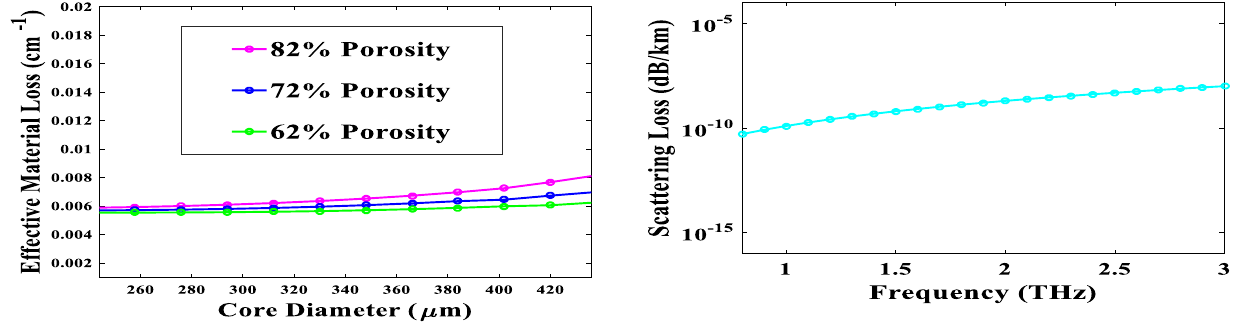
Fig. 6 Relative Sensitivity of EML with the variation of core diam- eter (micro-meter) for various porosity level